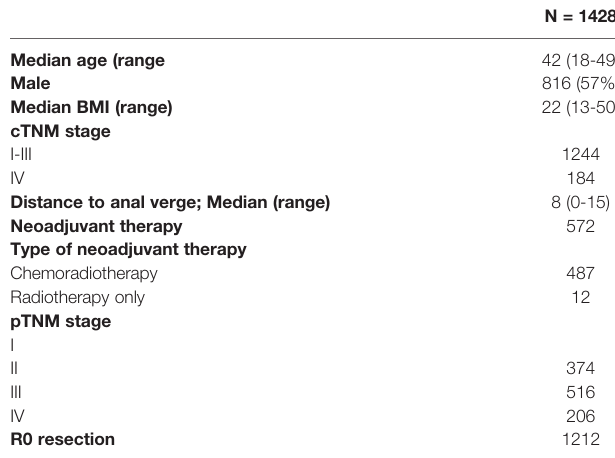
TABLE 1 | Baseline demographics and clinical